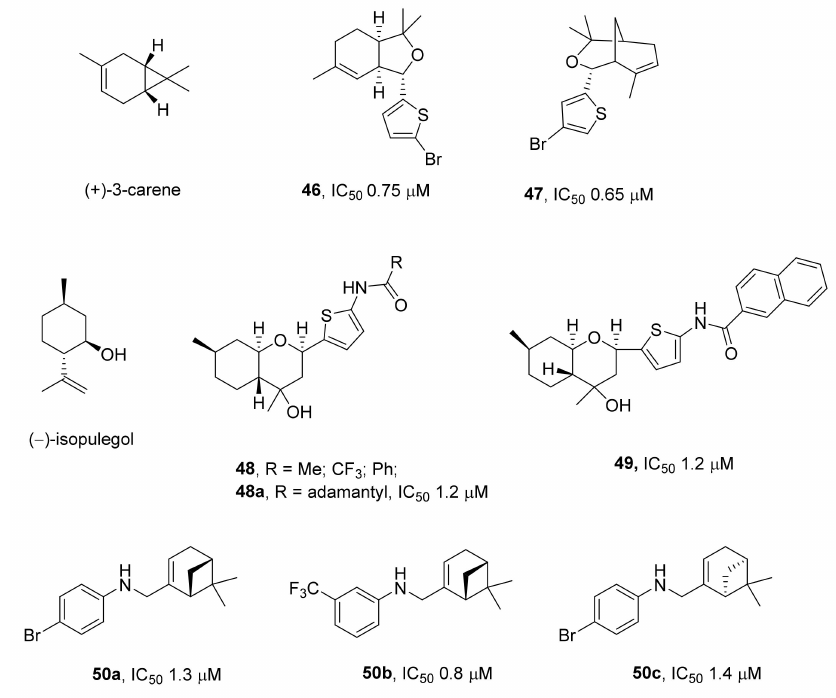
Figure 14. Monoterpenoid derivatives as inhibitors of